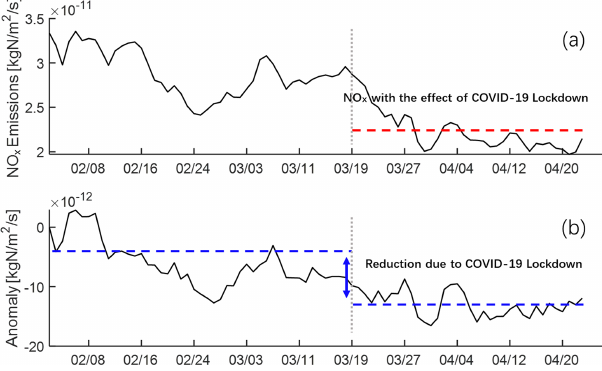
Figure 2. Satellite-derived NO x emission estimates in southern Cal- ifornia. (a) Daily NO x emissions from 1 February to 23 April 2020. The red line represents the average emissions during the period af- ter 19 March. (b) NO x emission changes due to COVID-19 (i.e., the anomaly), which are quantified using the difference between the real-world NO x emissions and the emissions in a hypothetical sce- nario without considering COVID-19. The emissions in the hypo- thetical scenario are estimated based on emission trends in prior years (2017–2019) using 1 February as a reference. The difference between two blue dashed lines represents the average reductions of NO x emissions induced by the COVID-19 lockdown measures that took effect on 19 March. The local valley between 24 February and 3 March is caused by retrieval uncertainties due to unfavorable meteorology conditions and is thus excluded when we estimate the average NO x emissions before the